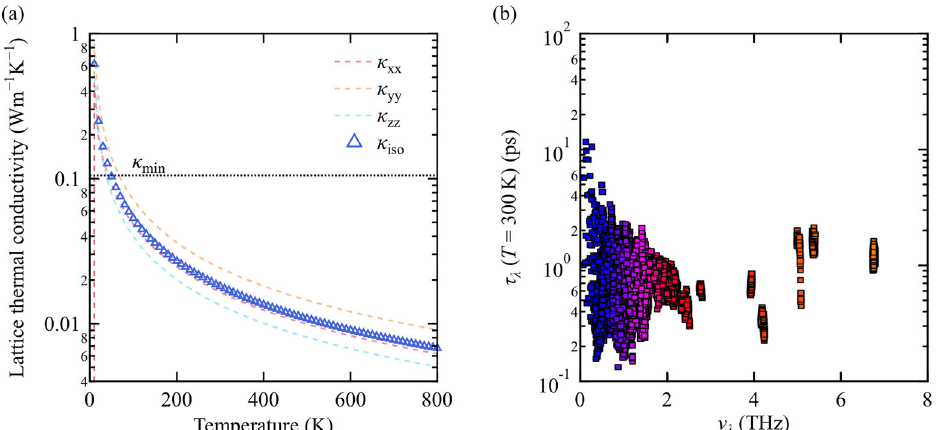
Fig. 2 Lattice thermal conductivity analysis. a Lattice thermal conductivity, calculated from direct solution of linearized phonon Boltzmann equation, of Cs 3 Cu 2 I 5 as a function of temperature. The red ( κ xx ), orange ( κ yy ), and sky blue ( κ zz ) dotted lines indicate direction dependent lattice thermal conductivity that are parallel to a -, b -, and c -axes of the primitive cell. The blue triangle markers ( κ iso ) show the isotropic average of the thermal conductivity tensor ( κ iso = [ κ xx + κ yy + κ zz ]/3). κ min refers to the minimum lattice thermal conductivity in a diffuson- mediated transport model. b Phonon lifetime ( τ λ ) at 300 K as a function of mode frequency ( ν λ ). The color gradient is given by phonon band